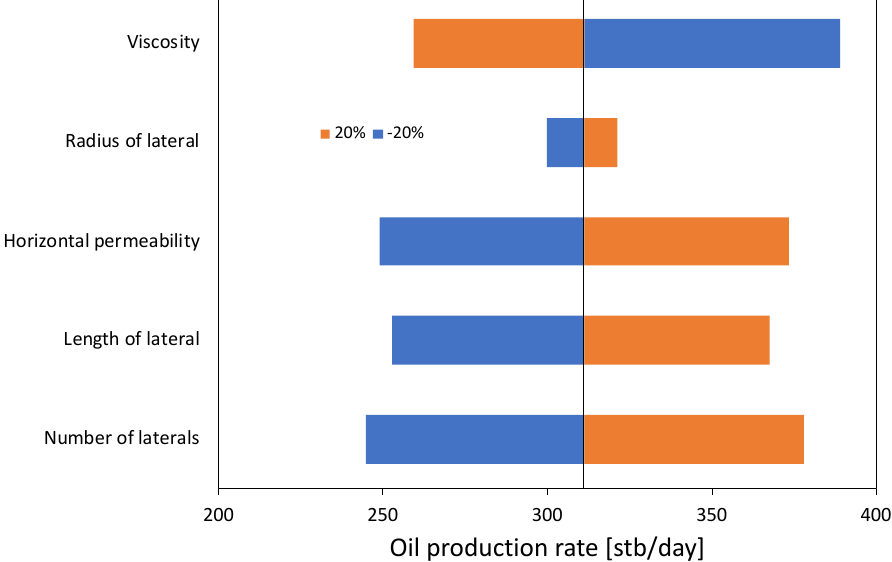
Figure 16. A Tornado chart comparing parameter sensitivities .